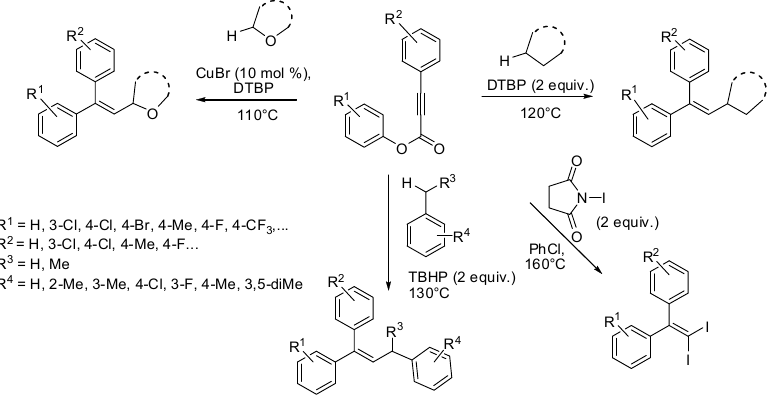
Scheme 14. Functionalization of aryl alkynoates via radical cascade.